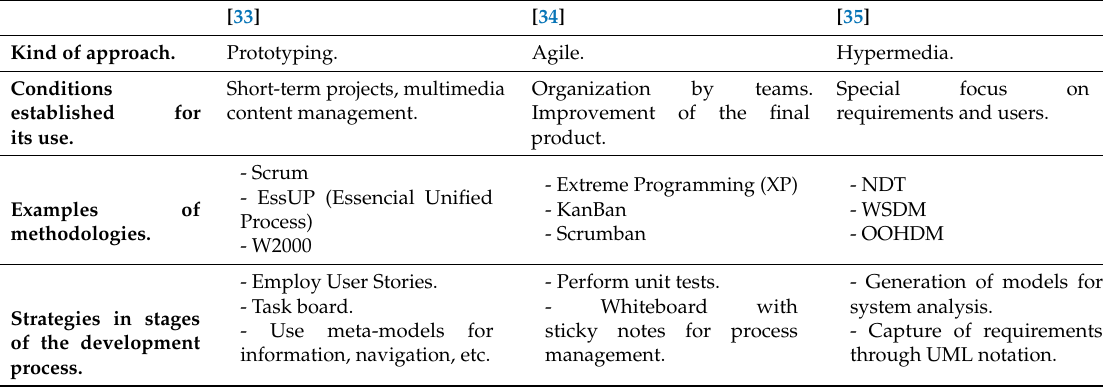
Table 8. Analysis of data extracted from primary studies regarding agile approach.